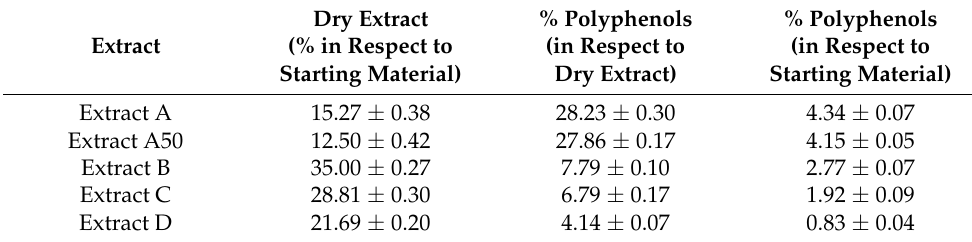
Table 2. Total polyphenol content calculated in respect to the dry extract and to the starting material. % Polyphenols Dry Extract (in Respect to Extract (% in Respect to Dry Extract) Starting Material) Starting Material)